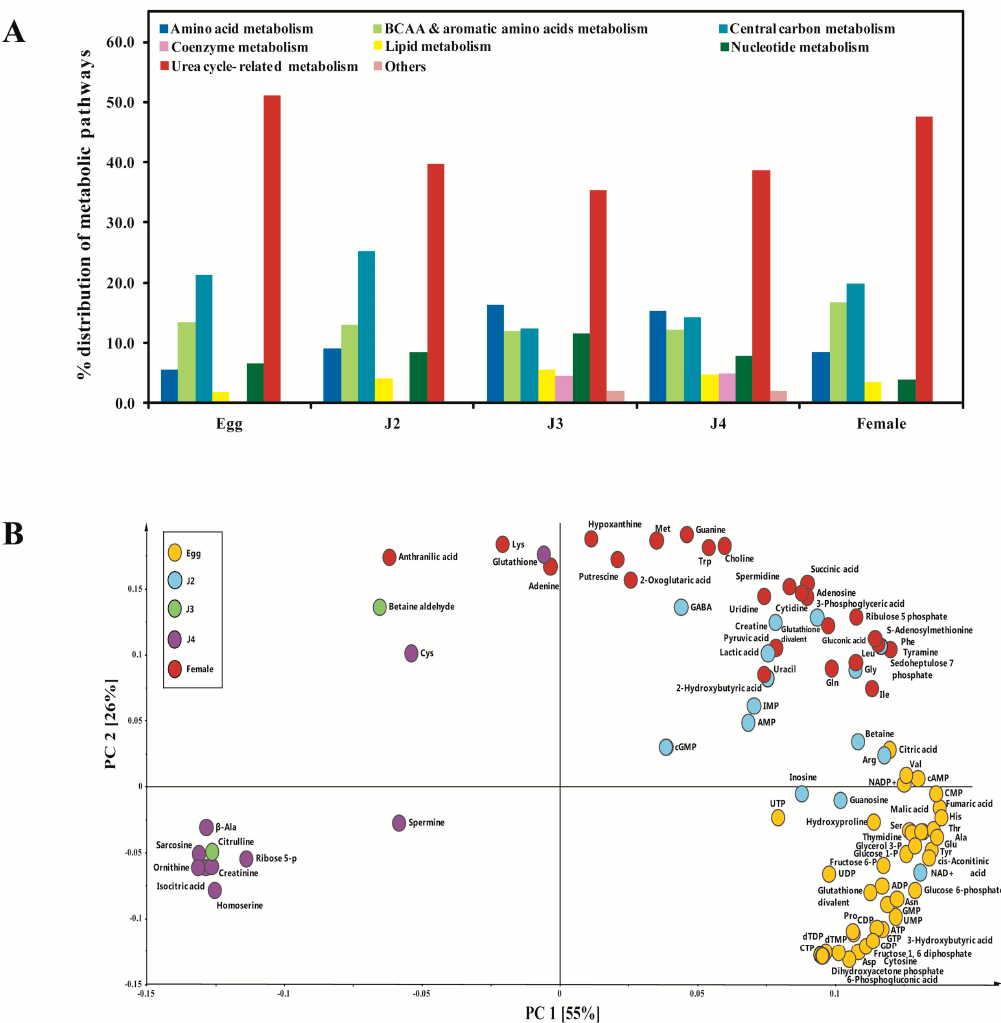
Figure 1. ( A ) Diversity of the metabolites observed at each stage of the nematode life cycle indicating major metabolic pathways of the cellular metabolism to which they constitute; ( B ) PCA loading plot of the two first principal components of the metabolites of M. incognita at various stages. The sum of two components amounted to 77.8%. Here, the metabolites can be observed to be grouped based on the stages where their expression has been significantly observed. The colored dots indicate the stage at which the particular metabolite showed highest